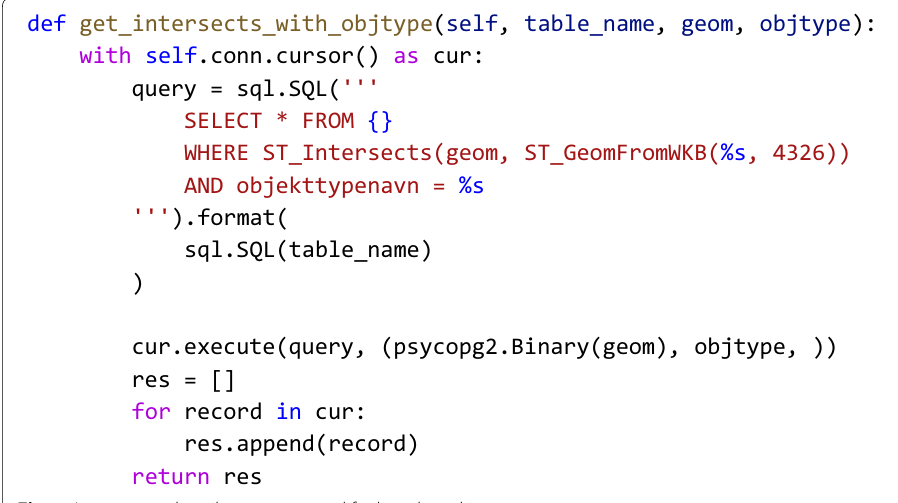
Fig. 7 Intersect and attribute query used for